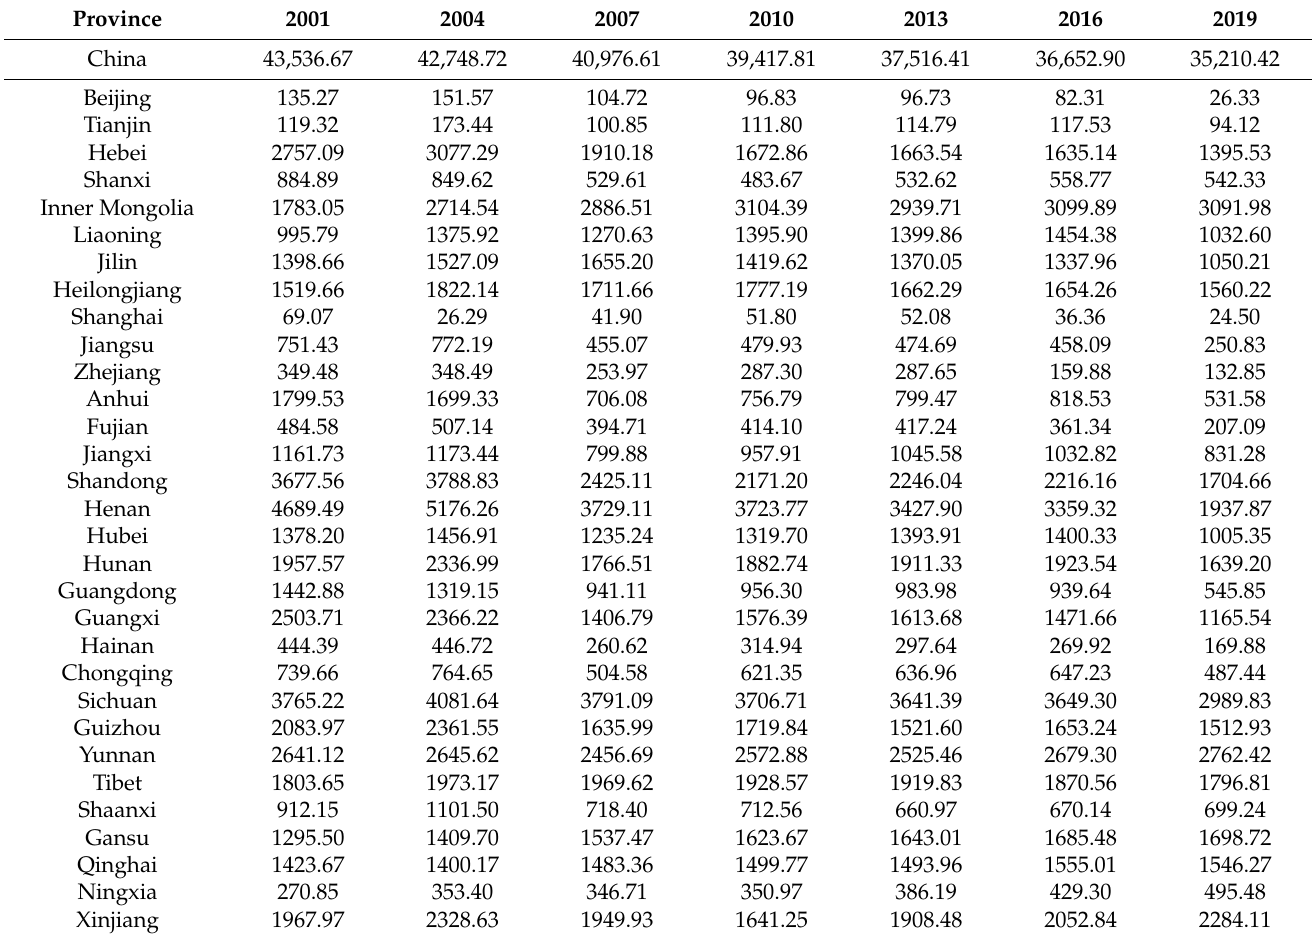
Table 4. The results for total carbon emissions from animal husbandry from 2001 to 2019 (units: 10,000